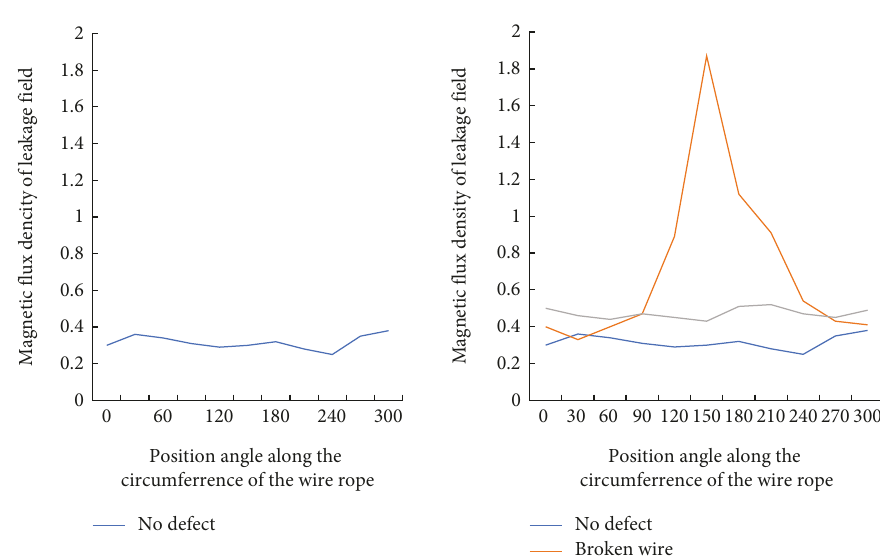
Figure 12: The change curve of the leakage MF at the damage of three different steel wire cross-sectional areas with a lift-off value of 0.5mm.